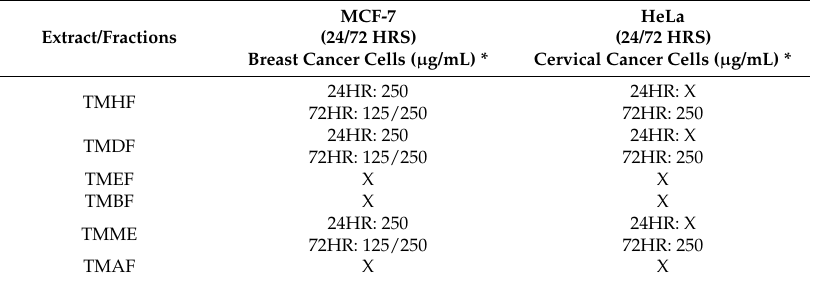
24HR: 250 72HR: 125/250